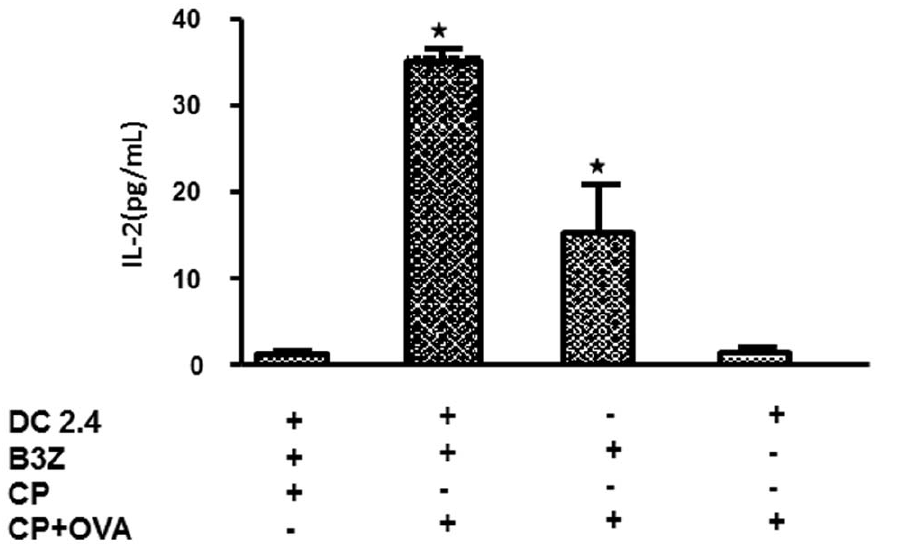
Figure 2. Vault nanocapsules induce cross presentation to CD8 cells. B3Z cells (1 6 10 5 cells/200 uL/well) were co cultured with DC 2.4 (5 6 10 4 cells/200 m L/well) in the presence or absence of CP-OVA (3.3 m g/200 uL/well) for 24 hrs. Control vaults (CP) were also used at concentration of 3.3 m g/200 uL/well. Following 24 hrs, T cell activation was analyzed by measuring IL-2 production. Data in all panels are representative of 3 independent experiments. Student’s t-test was used to determine statistical significance between the CP-OVA and control CP-vaults. *p ,